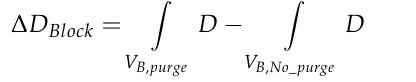
Table 3. Blocking loss (dm 3 ).